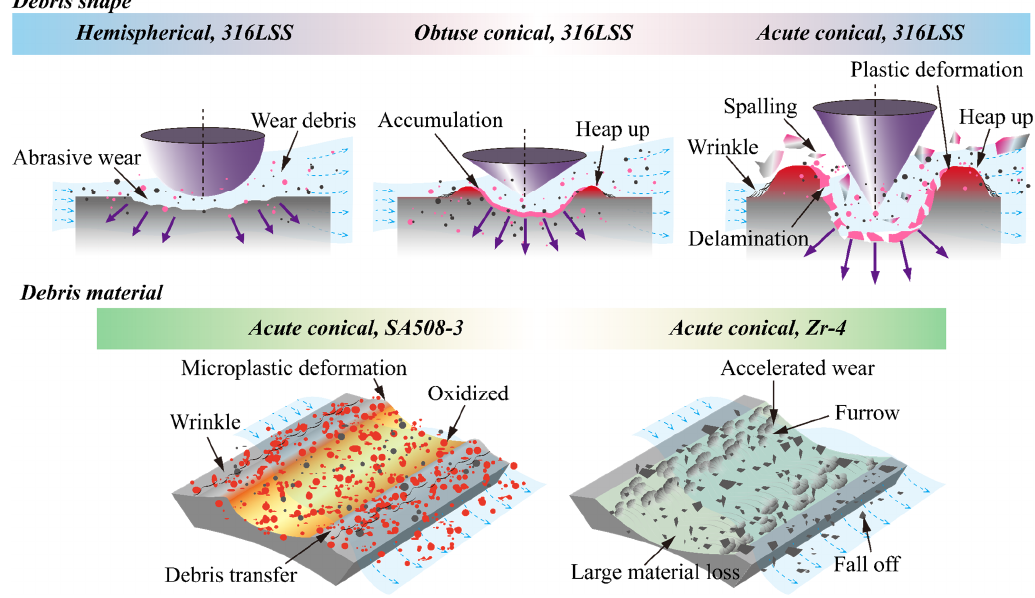
Figure 16. Schematic diagrams of the wear mechanisms.